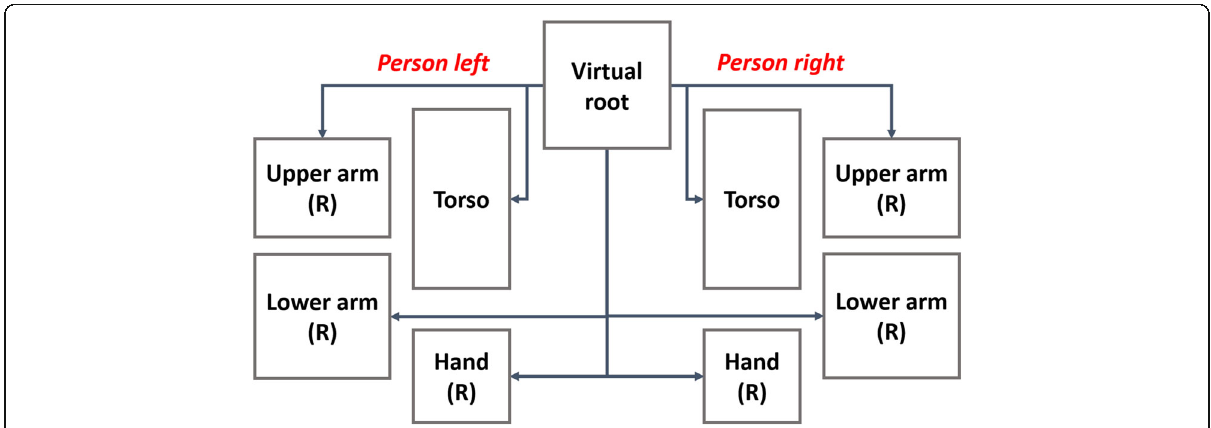
Fig. 3 Graph of the part configurations of our model. Both persons share the same virtual root part which encompasses the entire